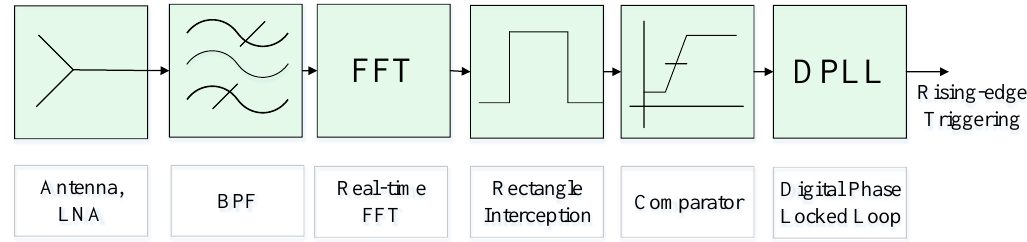
Figure 3. The flow chart for real-time